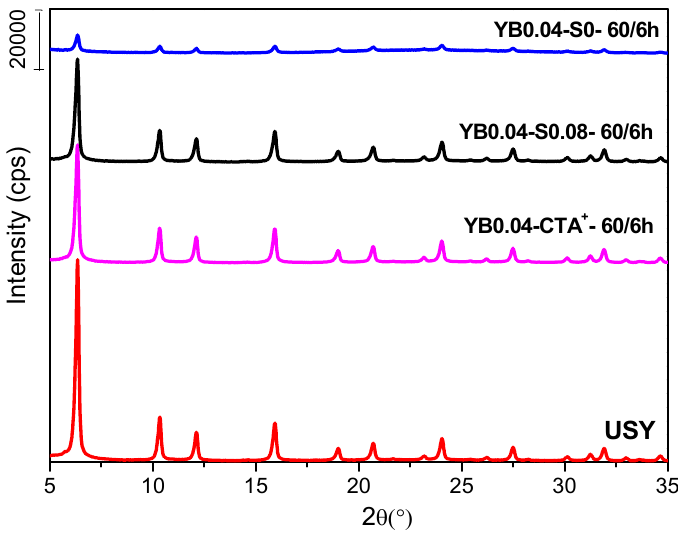
Figure 13. X-ray diffractograms of the zeolites used to study the influence of the presence of CTA + cations.